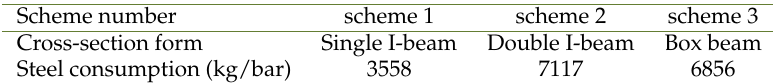
fractured boom according to the removal of the member method. Using the simplified calculation diagram in Fig. 6, a concentrated load equivalent to the fracture boom is ap- plied and the load combination is carried out considering the dynamic amplification factor = 1.6 [15]. In the boom equivalent effectiveness combination, the subfactor of the boom force under constant load is taken as 1.2, and the sub- factor under vehicle load is taken as 0.9. After obtaining the force state of the new steel longitudinal beam, the large longitudinal beam size can be